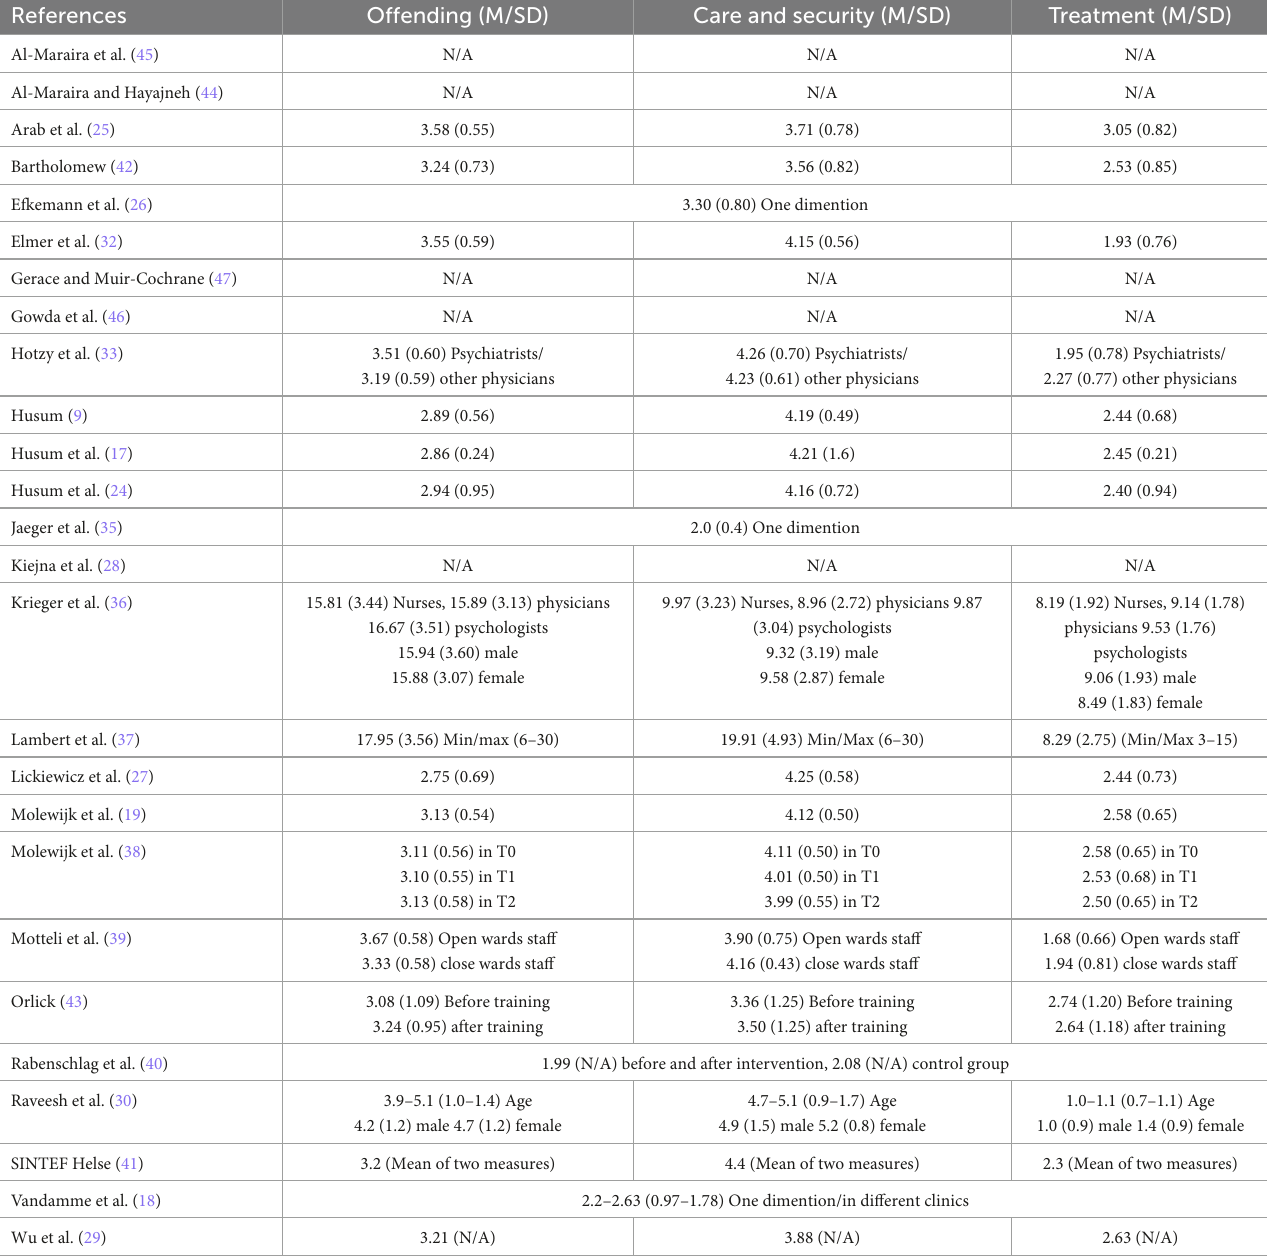
TABLE 2 ( ... ) Means and standard deviations of the individual studies included in